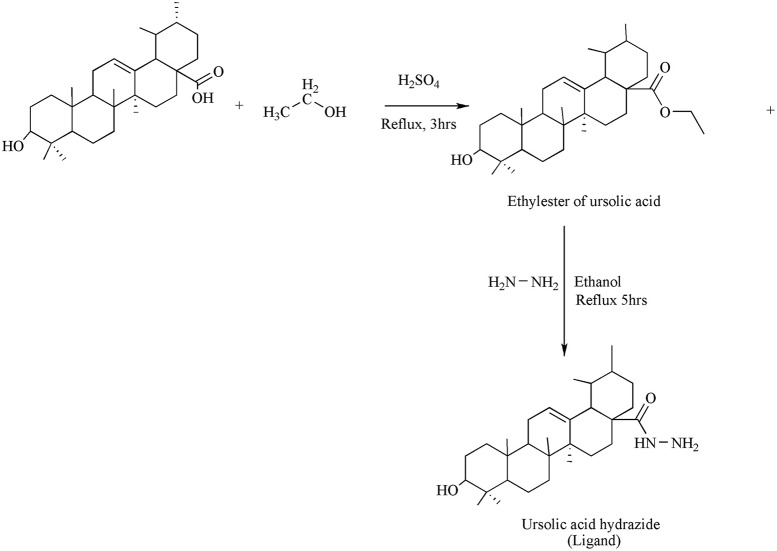
Synthesis of Ligand.